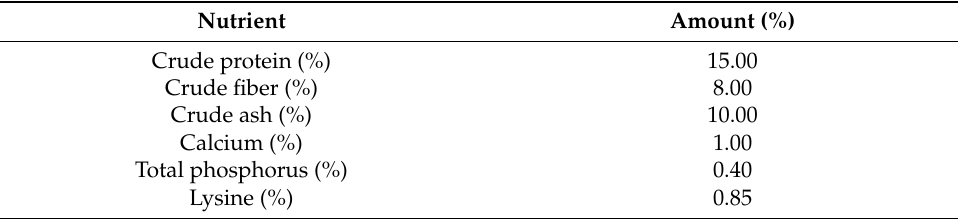
Figure 1. Schematic diagram of confinement stalls. Table 1. Nutritional composition of pregnant sow feed.